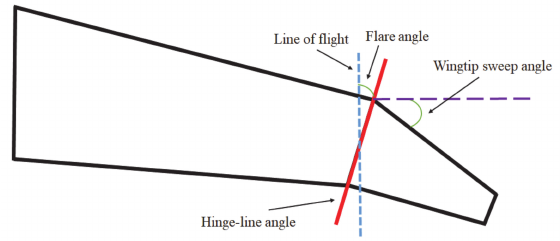
Figure 14. Wingtip sweep angle.